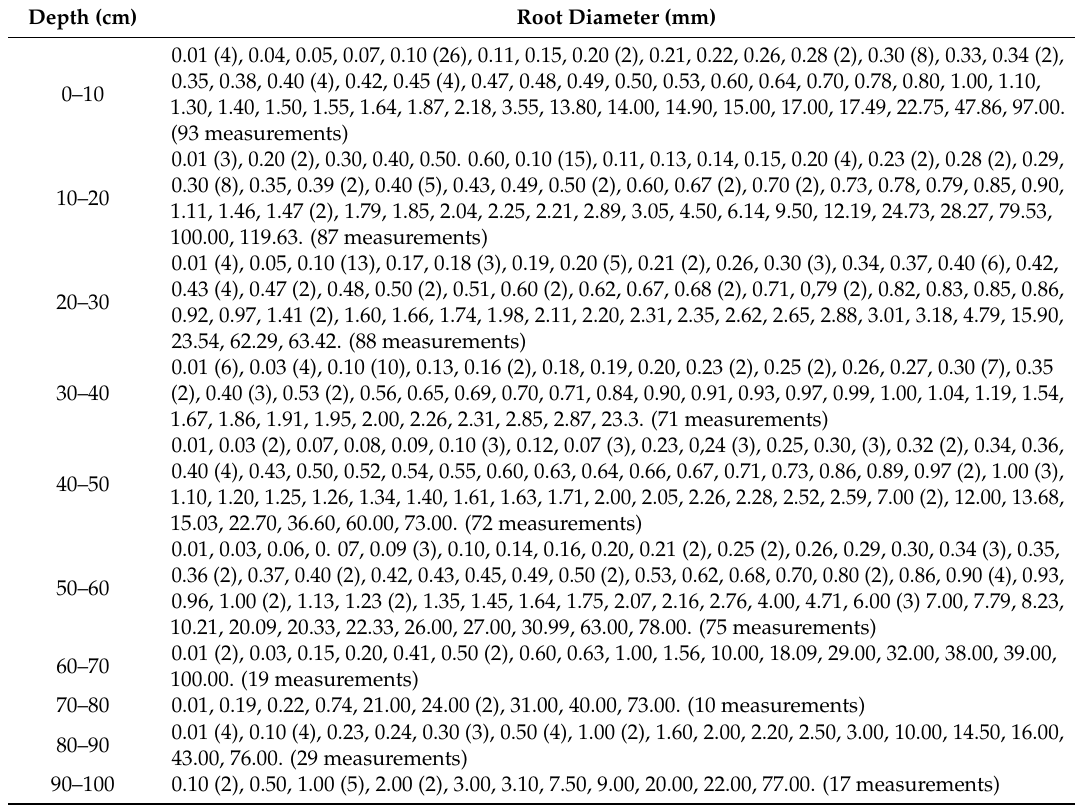
Table A6. Summary of all root diameters, in mm, measured for S. laevigata in depth increments of 10 cm from surface to 100 cm. Numbers in parenthesis show number of roots of that